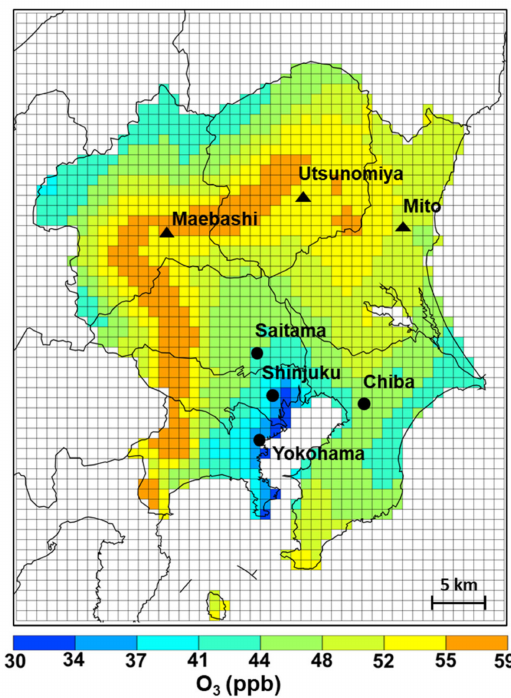
Figure 4. Eight-hour ozone concentration (10:00–16:00) distribution in the Kanto area during the 2016 ozone season for the base year scenario.